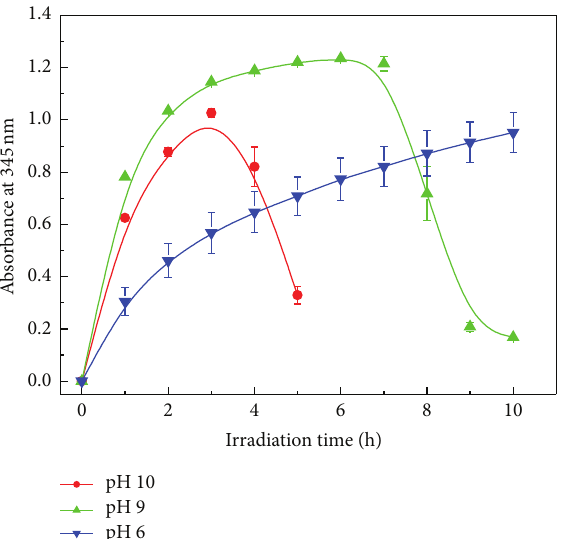
Figure 5: Kinetics of photoproducts formation monitored at 345 nm absorption peak at different pH values (6, 9, and 10). Concentration of 0.0625 g/L and temperature of 25 ∘